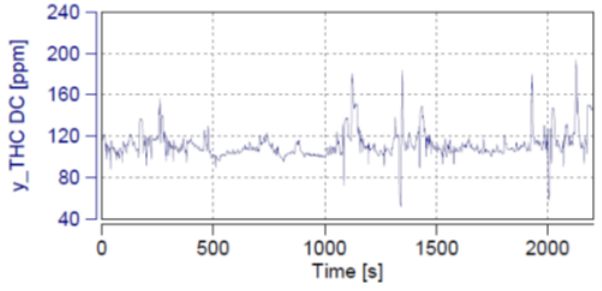
Fig. 10. Total hydrocarbons concentration during the test